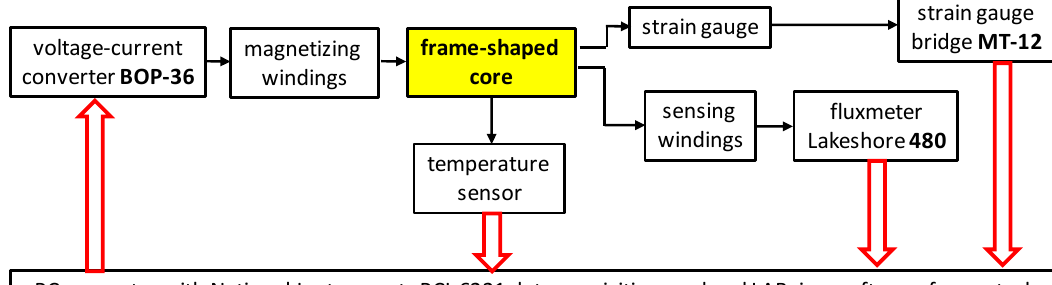
Figure 6. Schematic diagram of the system used for the measurements of magnetostrictive λ (B) and λ (H), as well as the magnetic B(H) hysteresis loops.